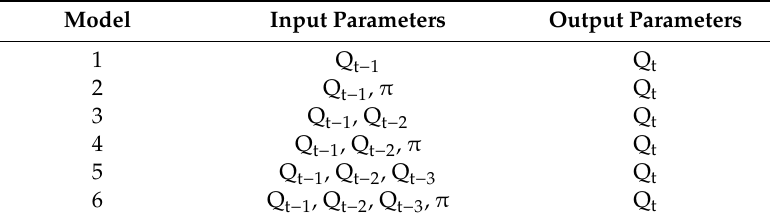
Table 2. Input parameters of the established